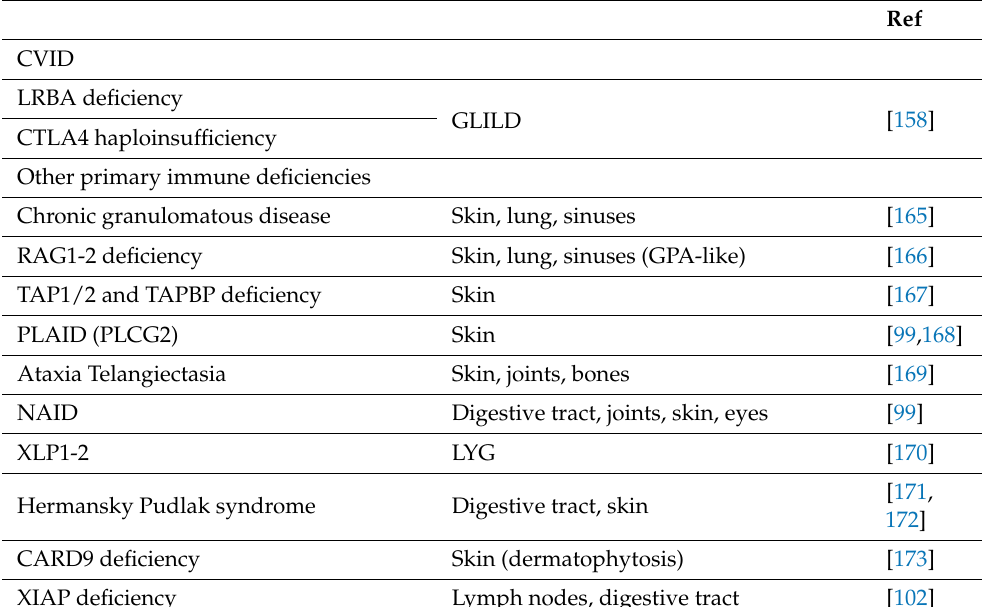
Table 4. Primary immunodeficiencies with granulomatous